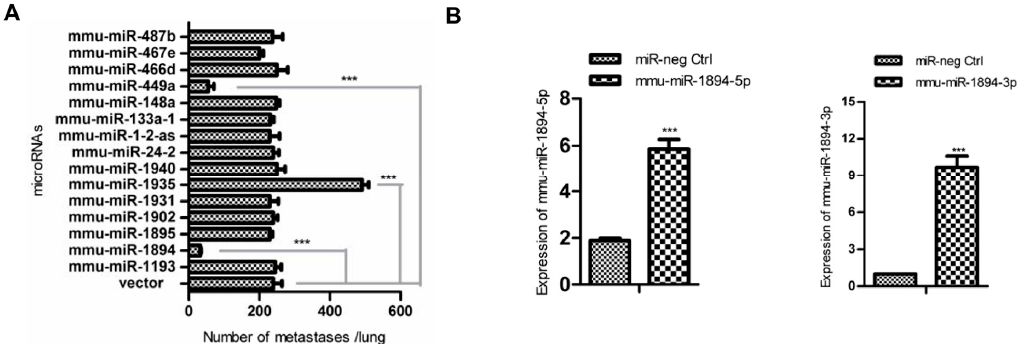
Figure 1. Cont. Figure 1.